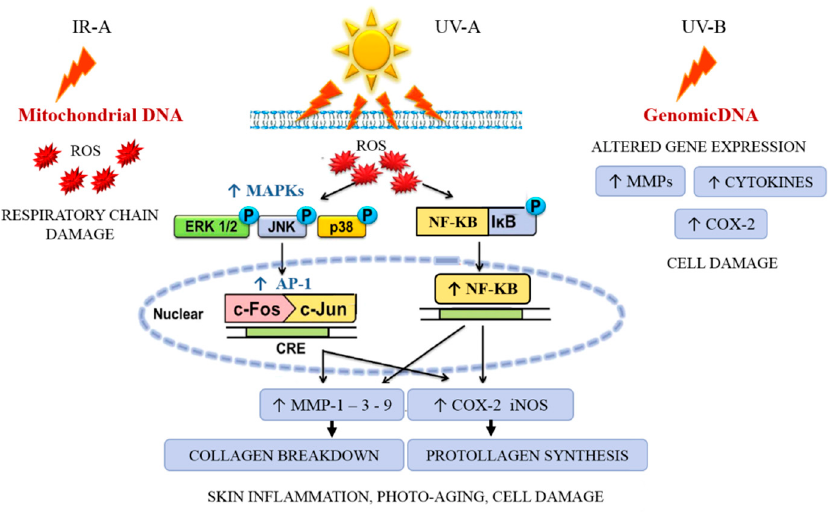
Figure 4. Sunlight UVB-induced inflammatory and photodamage.